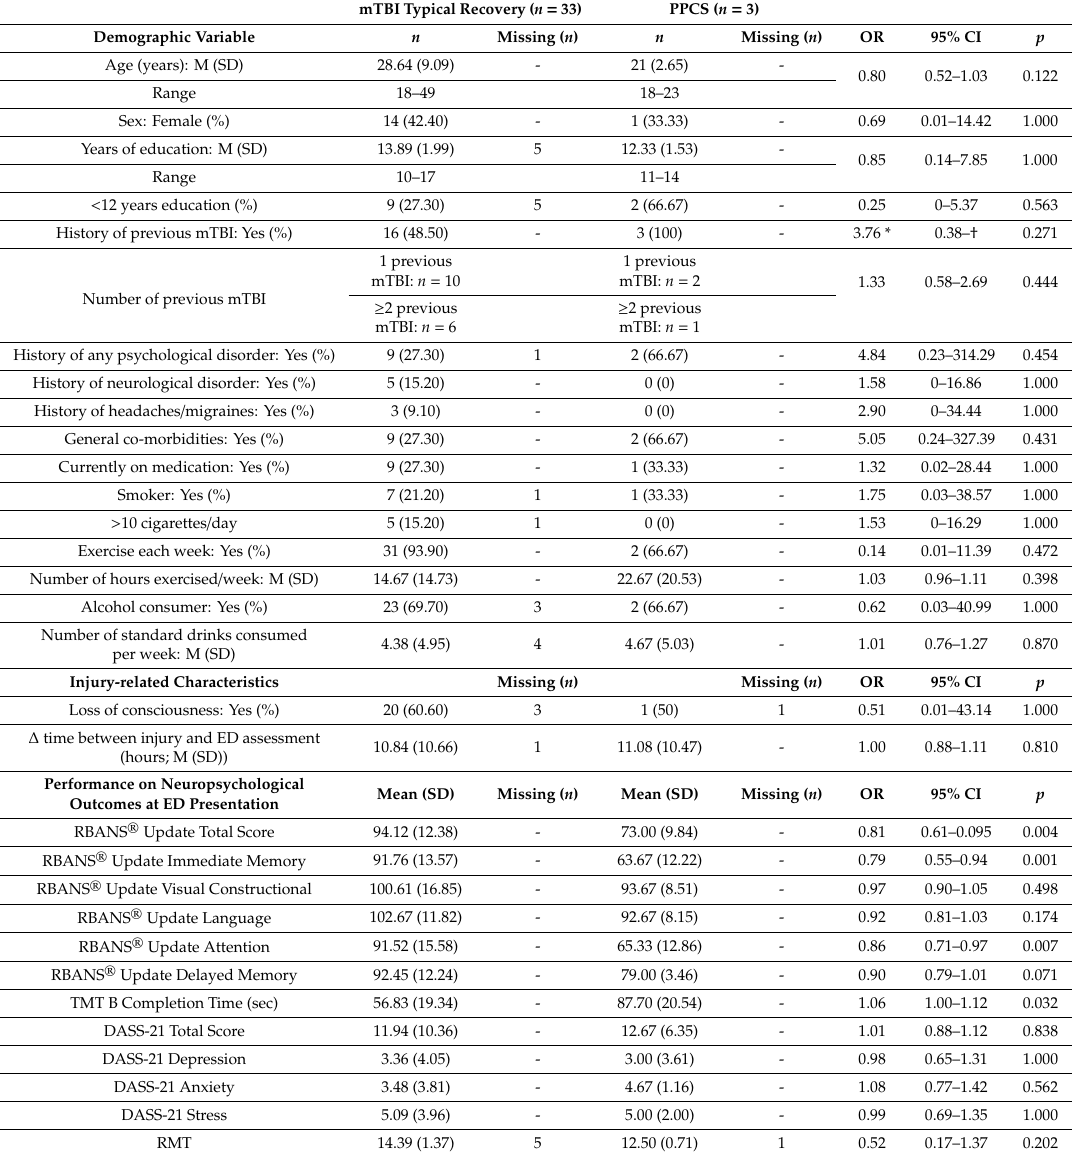
Table 2. Demographic variables, injury-related characteristics, and performance on neuropsychological outcome measures of participants who recovered typically and those who developed PPCS, with exact logistic regression odds ratios for